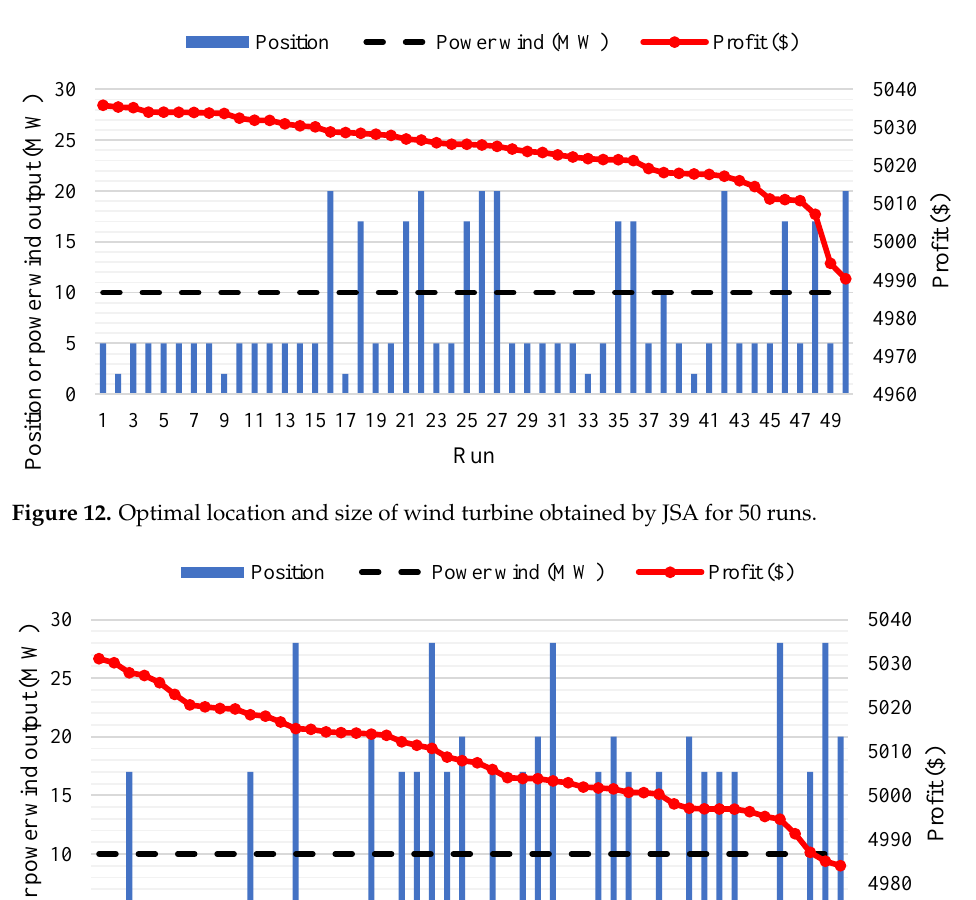
Figure 15. Optimal location and size of wind turbine obtained by SSA for 50 runs.